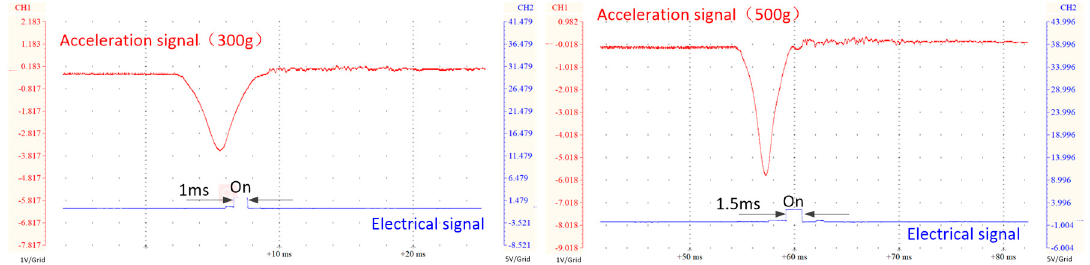
Figure 8. Measured switching profile of actuation versus signal voltages under different positions of electrode.